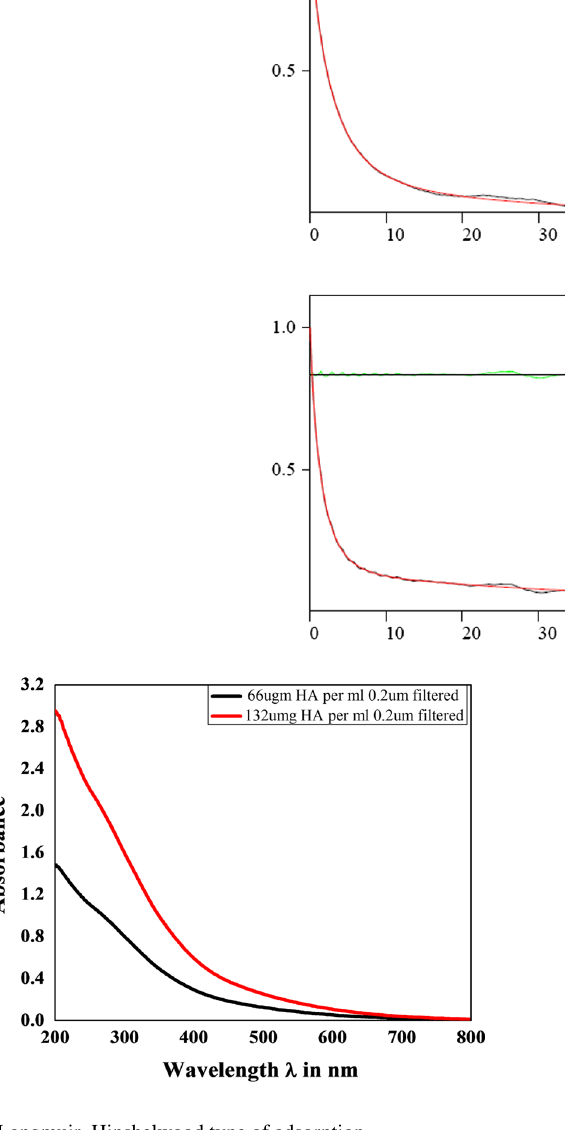
Fig. 5 Langmuir–Hinshelwood type of